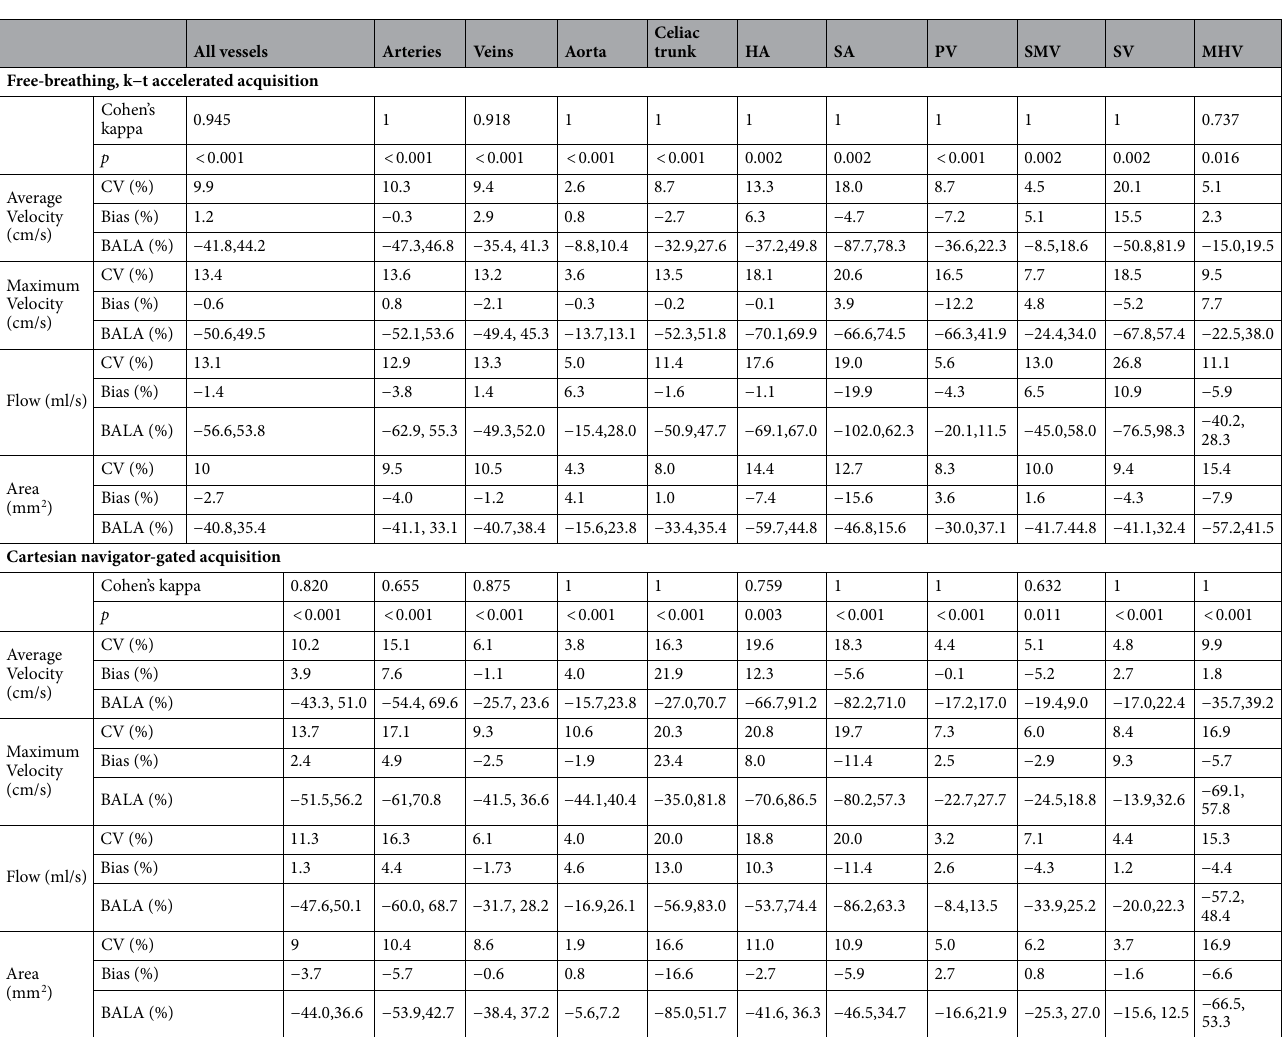
Table 2. Inter-observer agreement in vessel identification and flow quantification with the free breathing k−t accelerated and the standard Cartesian navigator-gated acquisition. Inter-observer agreement in vessel identification is measured by Cohen’s kappa. Inter-observer agreement of hemodynamic parameters is measured by inter-patient mean coefficient of variation (mean CV (%) = 100 SD/mean), Bland–Altman bias, and Bland–Altman limits of agreement (BALA). HA hepatic artery, MHV middle hepatic vein, PV portal vein, SA splenic artery, SMV superior mesenteric vein, SV splenic